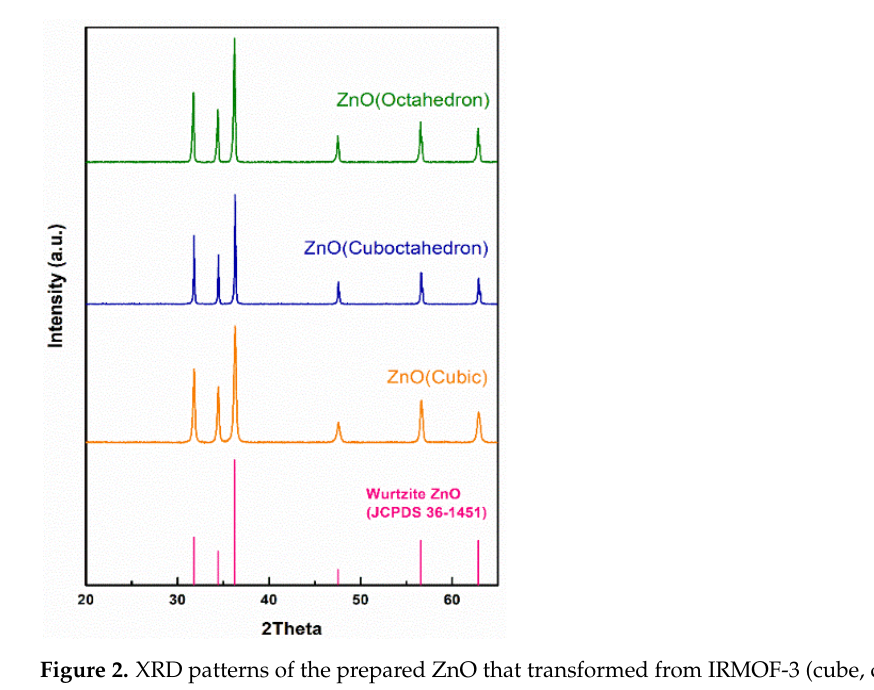
Figure 1. XRD patterns of all the synthesized IRMOF-3 samples and the simulated pattern for comparison.